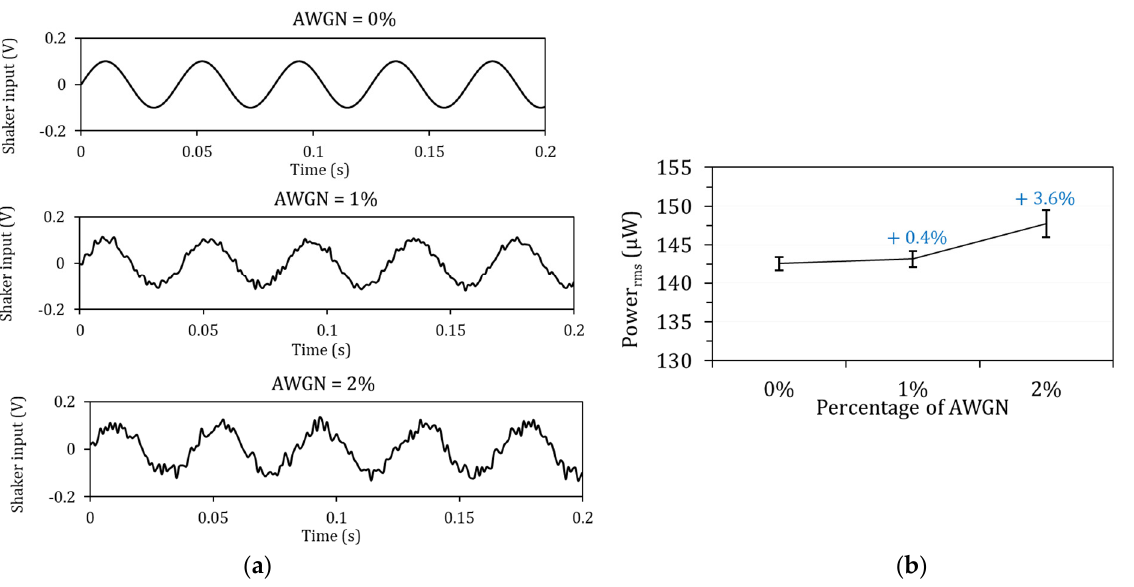
Figure 5. Effects of Added White Gaussian Noise (AWGN) on MFC power generation with funda- mental natural frequency excitation: ( a ) shaker vibration signals and ( b ) RMS power with R opt